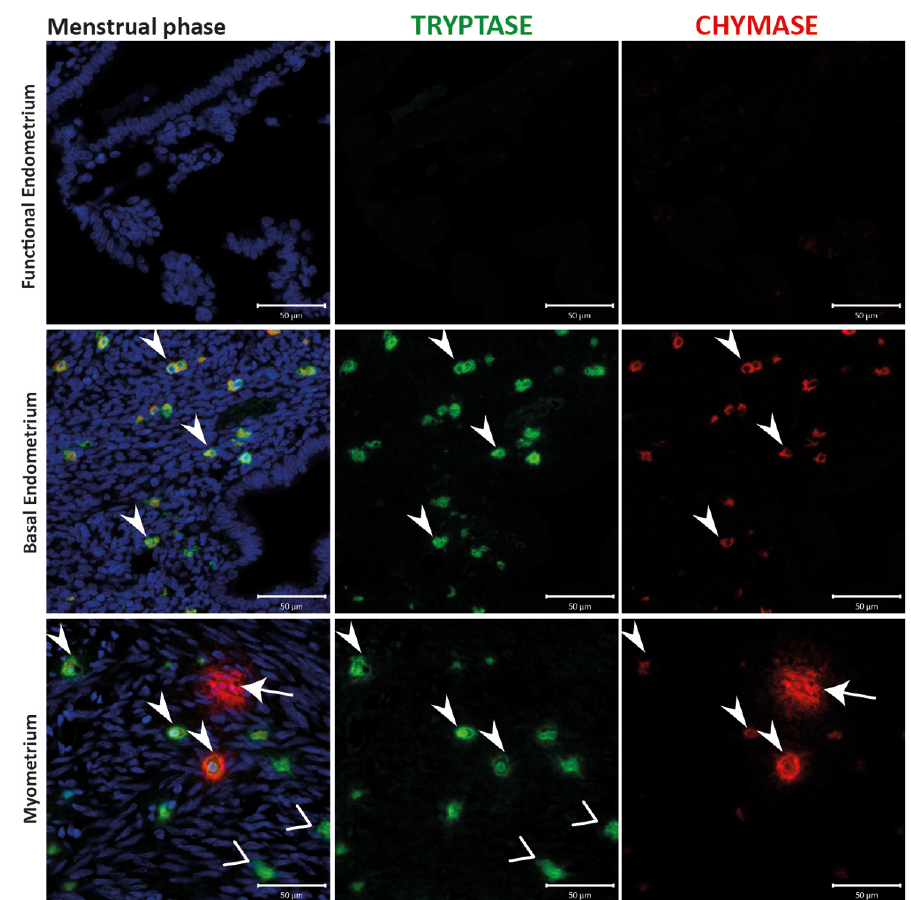
Figure 4. Samples from the menstrual phase contained chymase positive cells that appeared to be ‘activated’, as well as abundant double positive cells in the basal endometrium. Uterine mast cells (MCs) appear to be tryptase and chymase double positive, in both myometrial and basal endometrial layers, with a small portion of chymase+ MCs in the myometrium. MCs were not detectable in the functional layer. MCs during the menstrual phase appeared to be activated only in myometrial compartment, releasing both tryptase and chymase from the cytoplasm. In the basal endometrium, MCs showed a steady state instead. (n=2) (Arrowheads: MC cells).